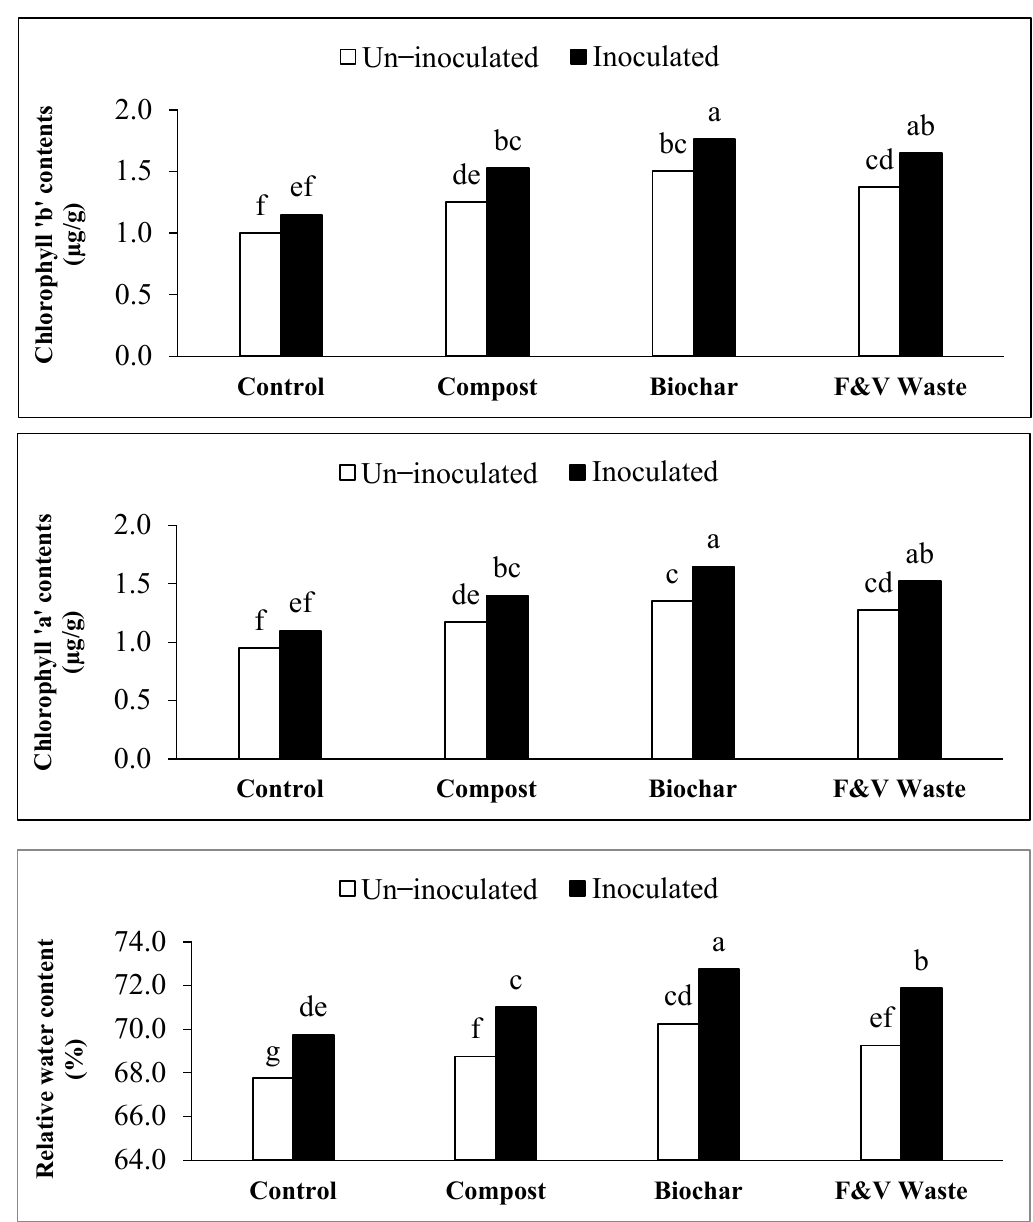
Figure 3. Effect of biochar, fruit and vegetable waste, compost and Bacillus subtilis SMBL 1 on relative water content, chlorophyll ‘a’ and ‘b’ in okra with un-inoculated treatment set (Control = no bacterial inoculation) and inoculated treatment set (Control = SMBL 1 only). Different letters indicate significant differences according to least significant difference test at ( p ≤ 0.05) .